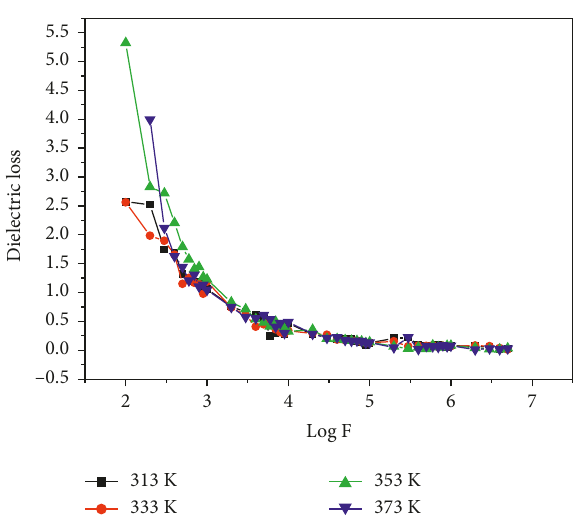
Figure 4: Dielectric loss vs log F of 3NPTAT.